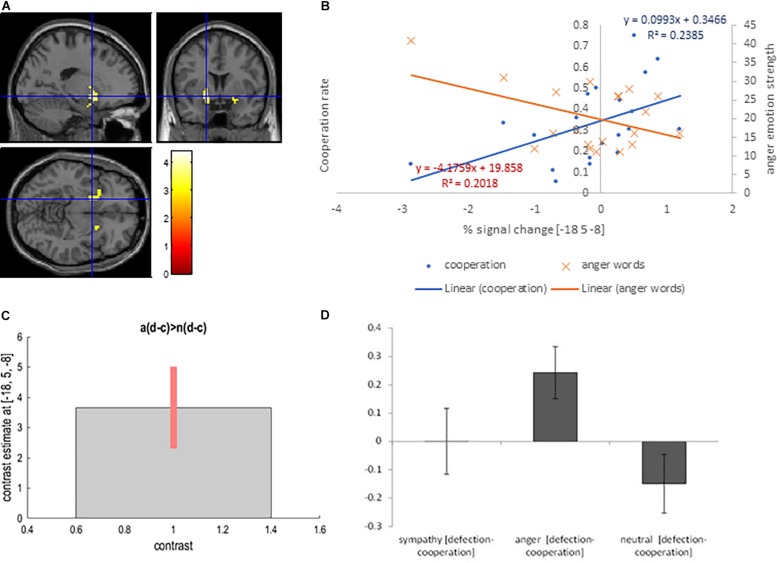
(A) Left amygdala activation overlaid on the MNI single subject template based on the interaction contrast [sympathy (defection – cooperation) – neutral (defection-cooperation)]; (B) Correlation between the interaction contrast percent signal change in the left amygdala and the cooperation rate in the sympathy condition (blue), and correlation between the percent signal change in the left putamen and the strength of sympathy word rating in the sympathy condition (orange); (C) Contrast estimate and 90% Confidence Interval for interaction contrast; (D) Difference in percent signal change between defection and cooperation trials in sympathy, anger and neutral emotion condition for interaction contrast.